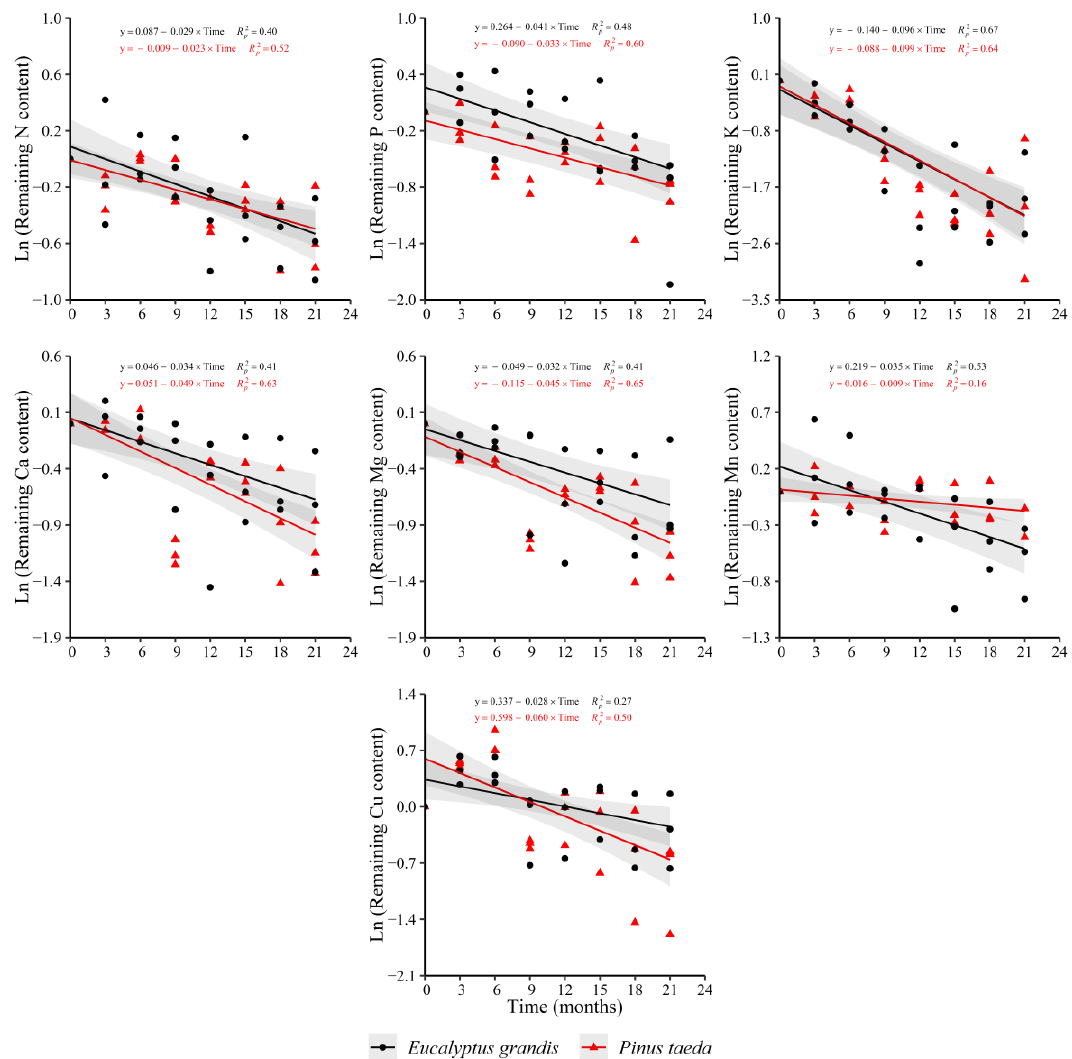
Figure 5. Remaining nutrient content of E. grandis (black symbols) and P. taeda (red symbols) litter for the different sampling moments (C1 layer). The gray bands around the models represent the 95% confidence interval.